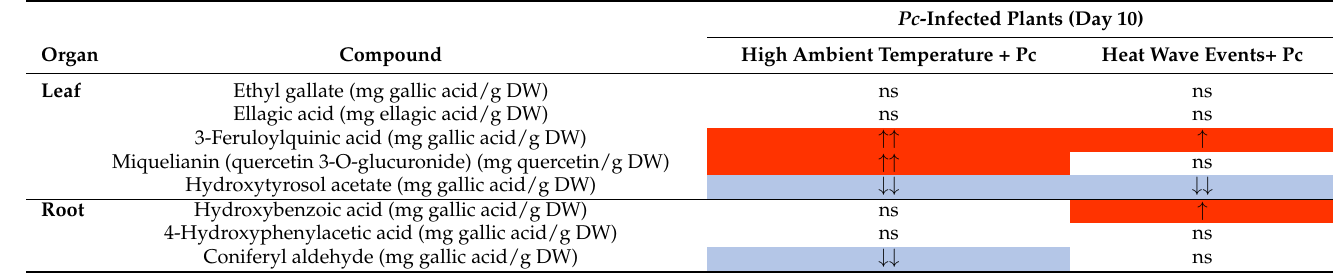
Table 5. Changes in phenolic compounds in leaves and roots of Phytophthora cinnamomi -infected Castanea sativa seedlings 0 and 10 days after exposure of plants to high ambient temperature and heat wave events compared to plants exposed to ambient temperature. Red and blue indicate increase and decrease, respectively. Two arrows indicate significant variation ( p < 0.05), one arrow indicates marginally significant variation ( p < 0.10), and ns indicates non-significant variation (Tukey’s HSD test). Pc -Infected Plants (Day